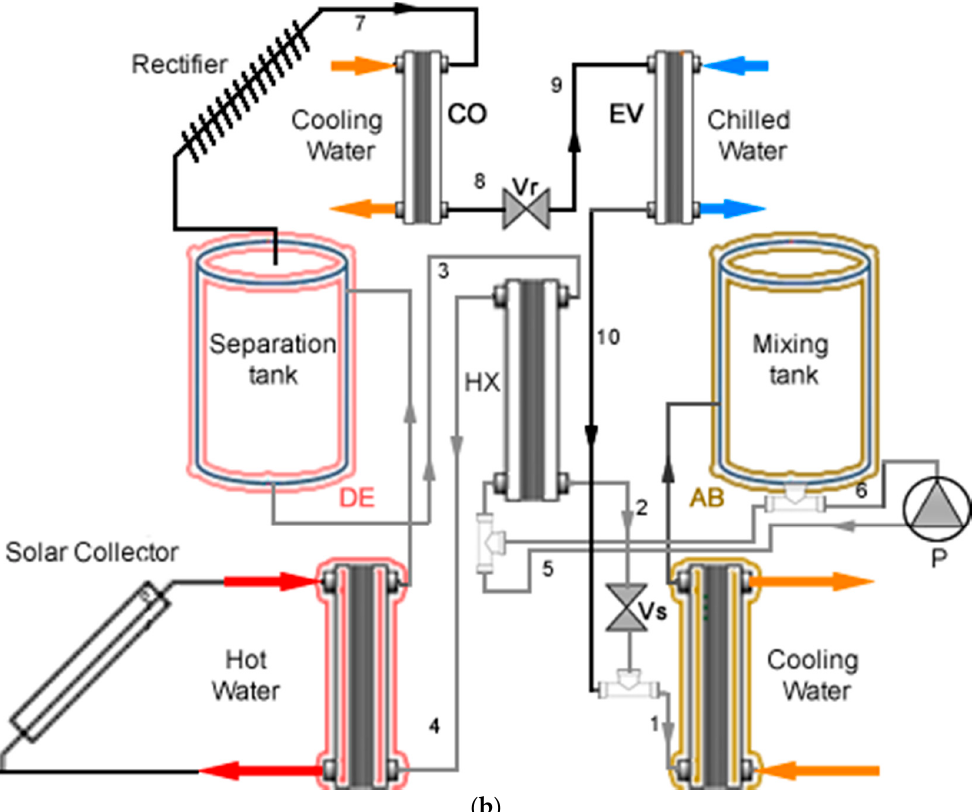
Figure 1. ( a ) Absorption cooling cycle. ( b ) Experimental diagram of the absorption cooling cycle. Colors indicate the correspondences of the components.